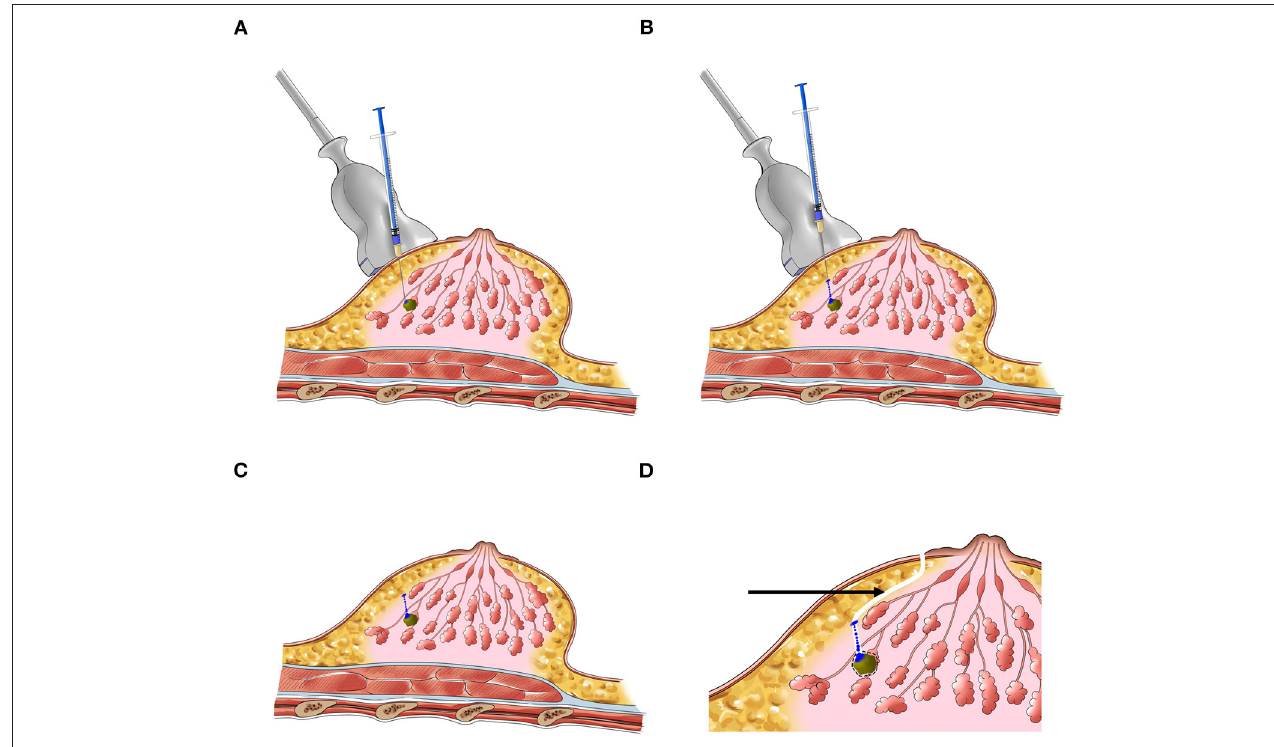
FIGURE 1 | The schematic diagram of preoperative localization of NPBL. (A–C) Injection process. (D) Surgery pathway (the black arrow).